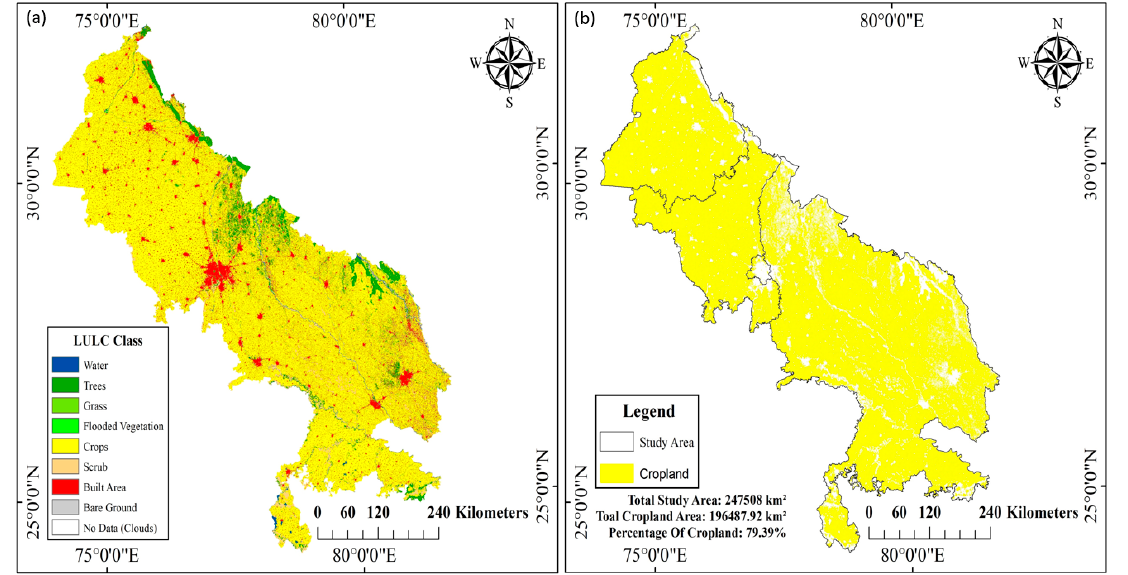
Figure 2. LULC of the study site for ( a ) year 2020 and ( b ) illustrates the agricultural area assessment in the selected region. in the selected